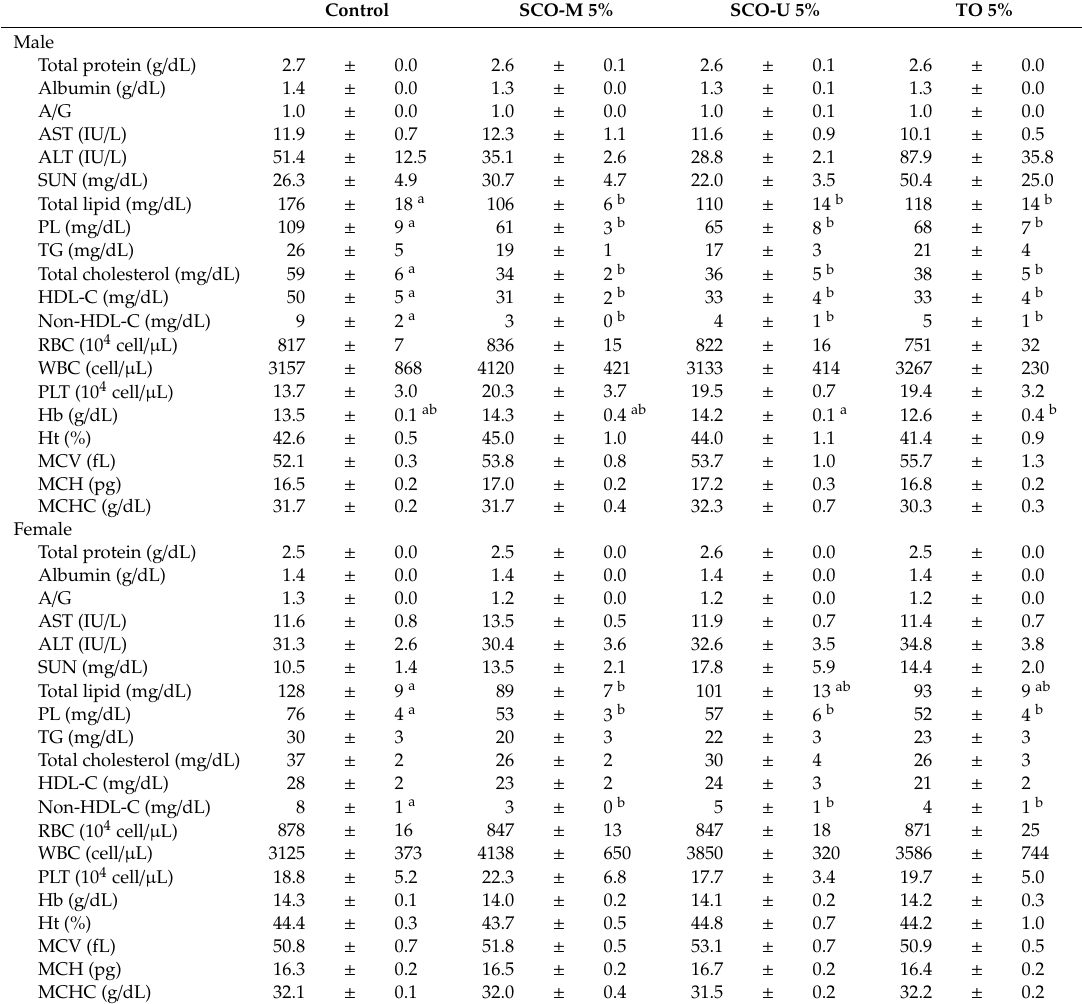
Table 4. The biochemical and hematological parameters of mice administered with scallop oil for 13 weeks. Control SCO-M